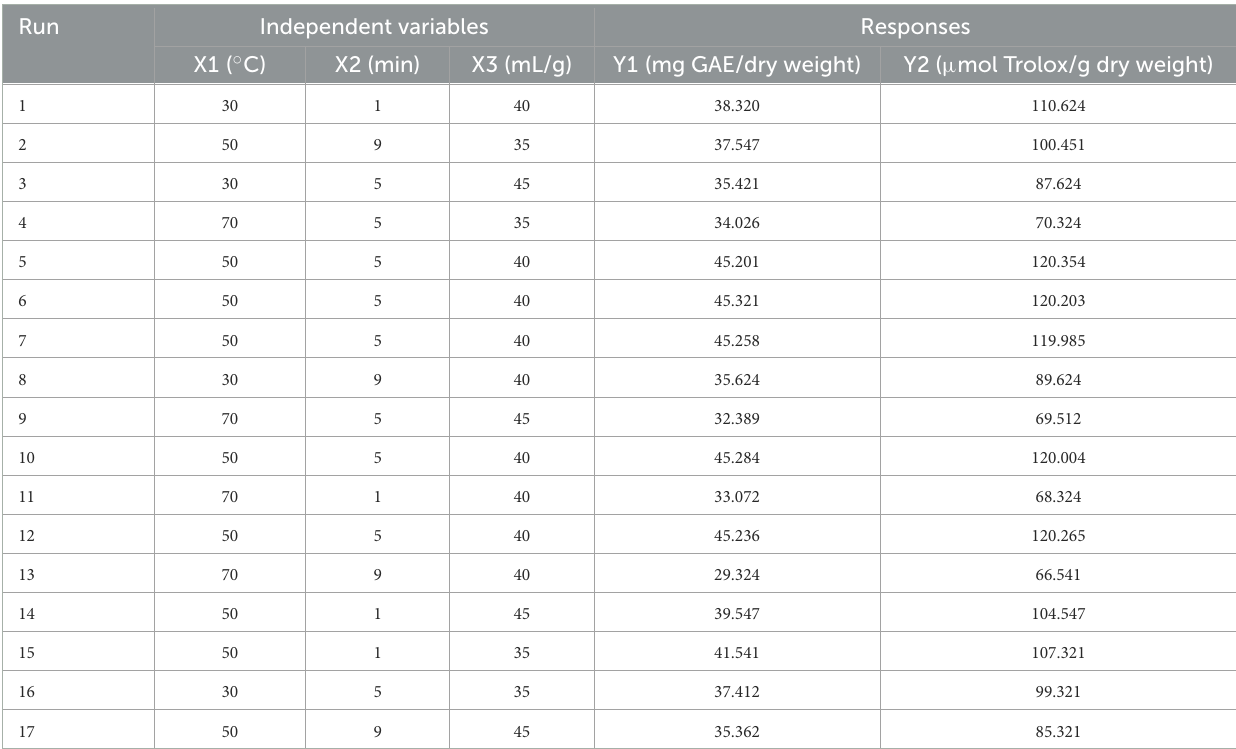
TABLE 4 Matrix of Box-Behnken design for three factors with water-soluble phenolic content and its DPPH scavenging activity. Run Independent